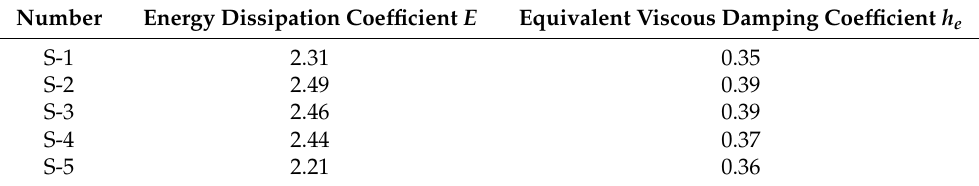
Table 4. S series joint energy consumption index.